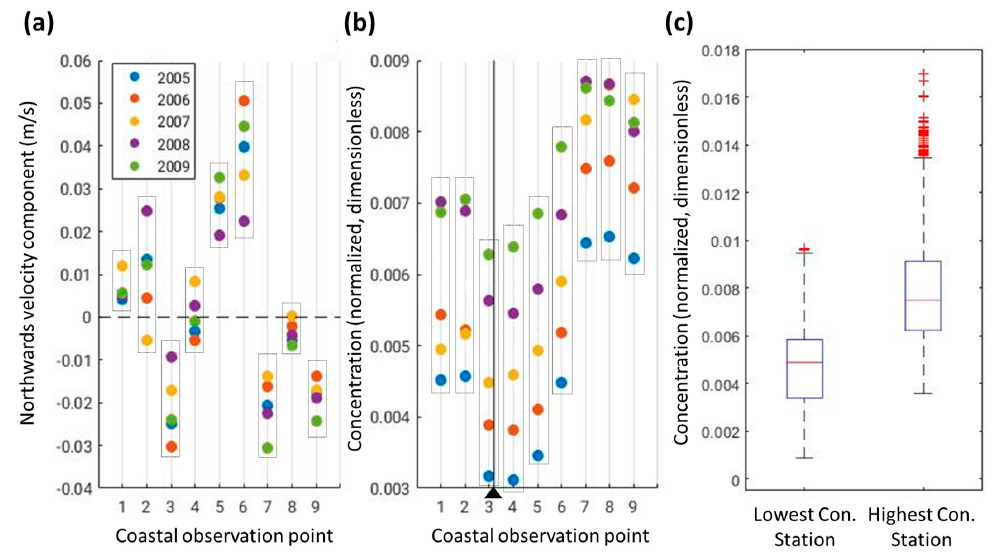
Figure 3. ( a ) Temporal average northwards velocity component (m/s). ( b ) Temporal average solute concentration (normalized, dimensionless). ( c ) Box-and-whisker plots of the statistics of concentration values (median, lower and upper quartiles, whiskers of 1.5 times the interquartile range, and individual outlier data outside of the whisker range) at the observation points with the lowest and the highest concentration. Results are for the Vistula River coast with the symbol (cid:78) in panel ( b ) indicating the solute source location along this